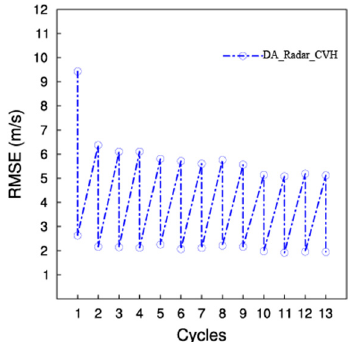
Figure 7. RMSE before and after the data assimilation from 0000 UTC on 13 September to 0600 UTC on September 13 for the 13 DA cycles for experiment